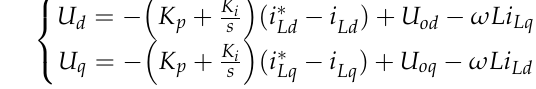
Figure 9. ( a ) PWM pulse. ( b ) Converter input and output voltage of PV.